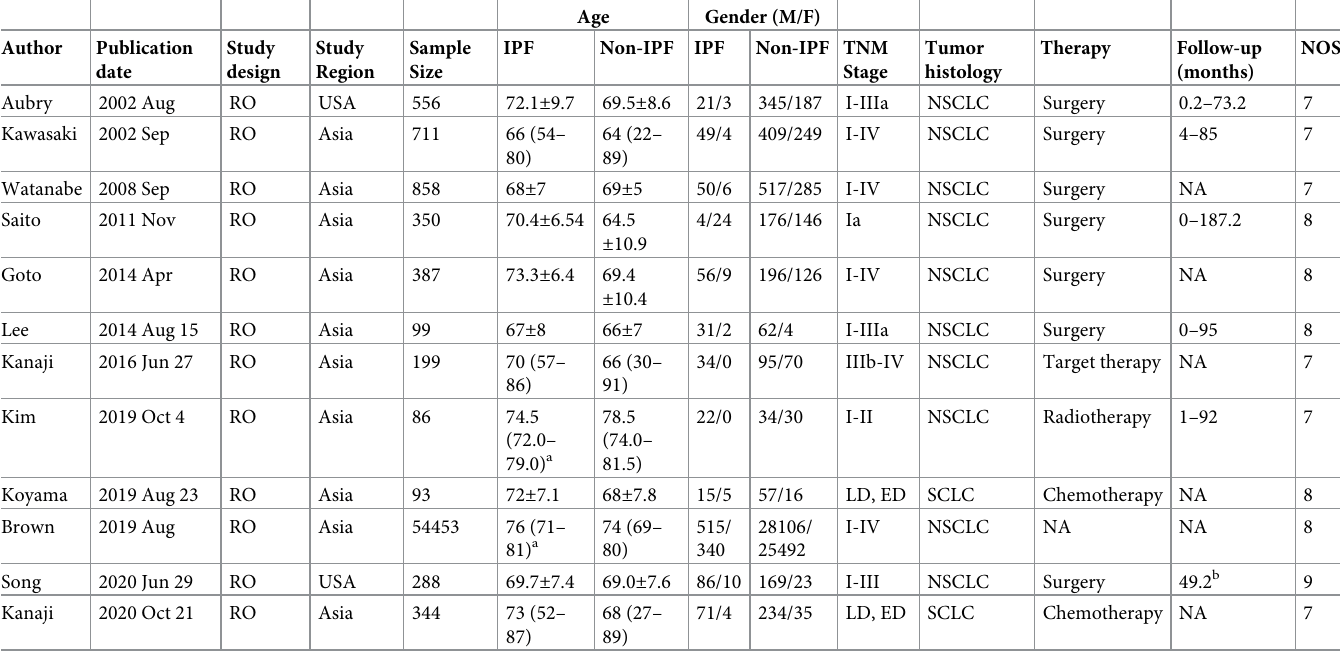
Table 1. Main characteristics of the studies included in this meta-analysis.